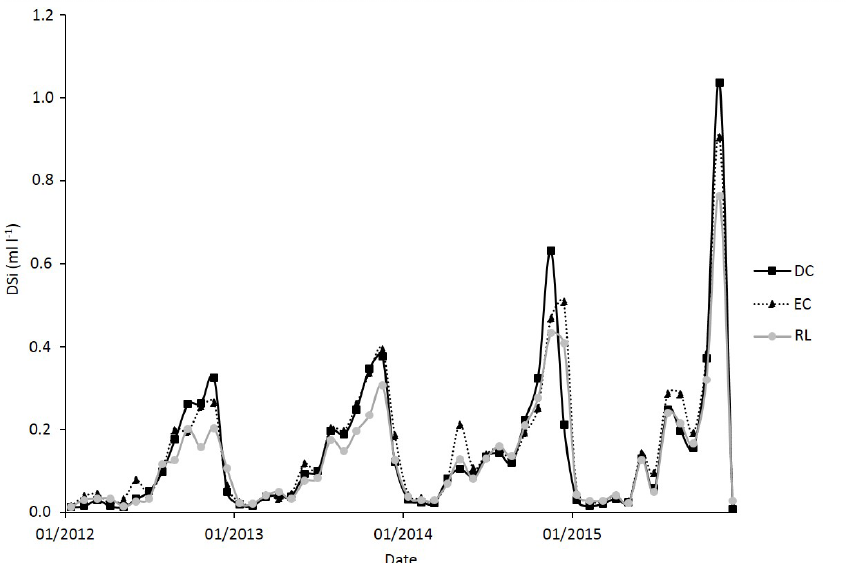
Figure 2. Seasonal dynamics over 4 years (January 2012 to December 2015) of DSi concentration in throughfall solution for the three plots, DC, EC and RL.